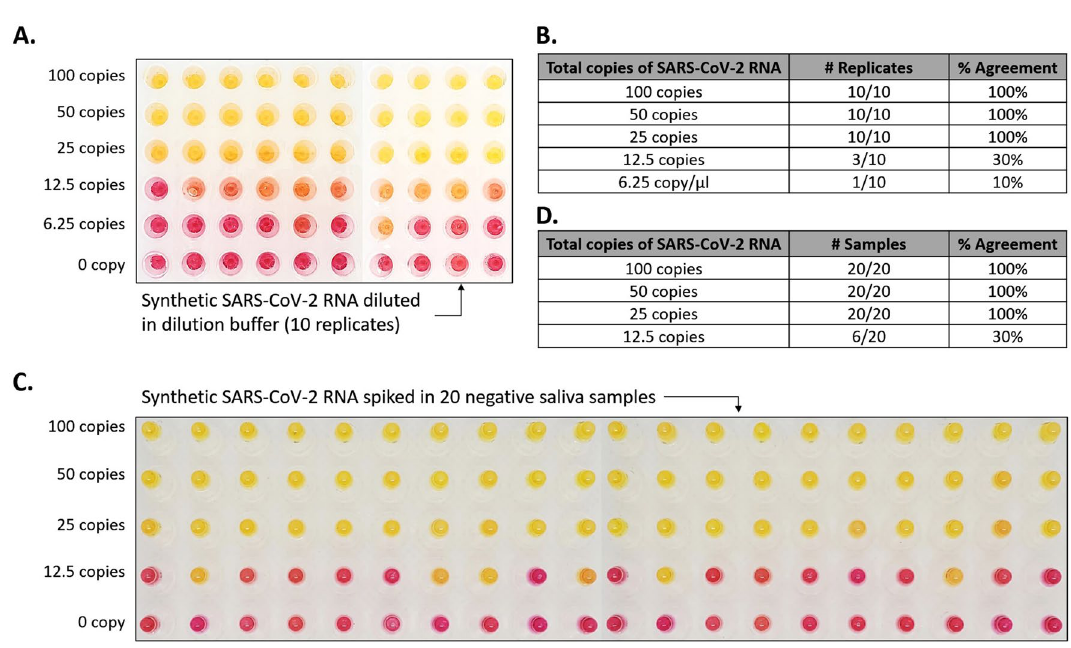
Figure 2. SARS-CoV-2 Detection Limit of SaliVISION Test Using Saliva Samples. Different concentrations of synthetic SARS-CoV-2 RNA was spiked in Dilution Buffer. ( A ) or negative saliva samples ( C ) and subjected to RT-LAMP analysis with SaliVISION test. The reactions were incubated at 65 °C in 30 min. The color change in each sample was captured immediately after the reactions were terminated, using a phone camera. The tables show a summary of positive reactions of 10 independent replicates of viral RNA directly added to Dilution Buffer ( B ) or of 20 negative saliva sampled spiked with viral RNA ( D ). The provided number in these figures and tables represents the actual copy number of viral RNA in each SaliVISION